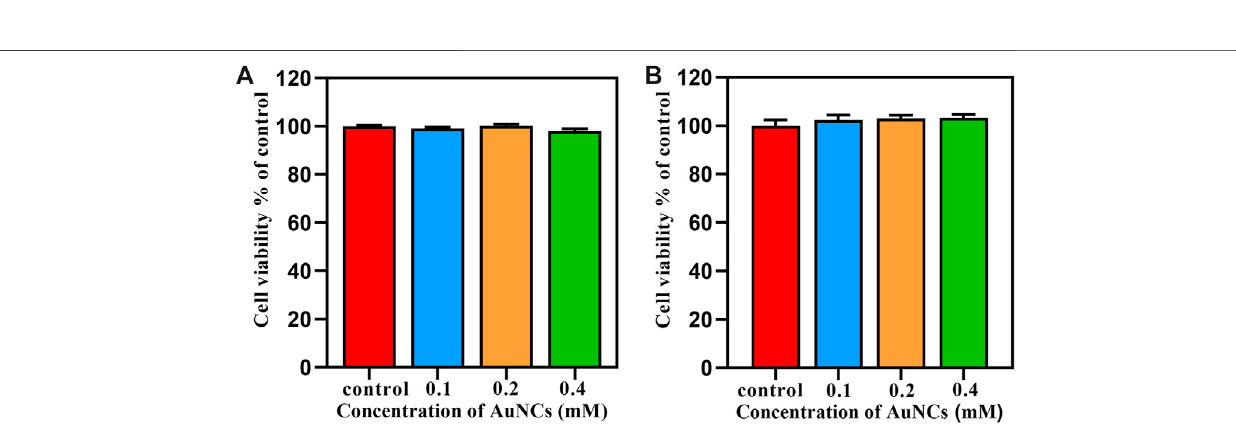
Frontiers in Materials |